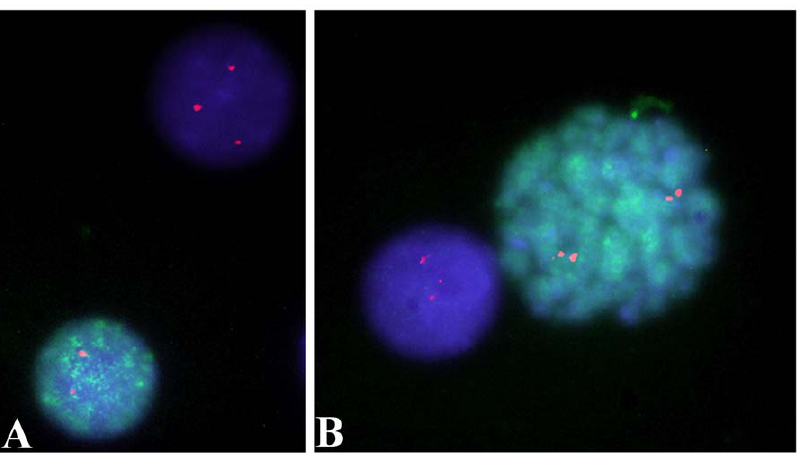
Figure 3. Example of Immuno-FISH performed on cells from patient no. 2. Anti-pKi-67 antibody is shown in green, whereas hybridization signals corresponding to the chromosome 19 specific probe RP11-197O4 is shown in red. (A): the nucleus with two FISH signals is pKi-67 positive, whereas the nucleus with three FISH signals is pKi-67 negative (B): the metaphase with two FISH signals is pKi-67 positive, whereas the nucleus with three FISH signals is pKi-67 negative.